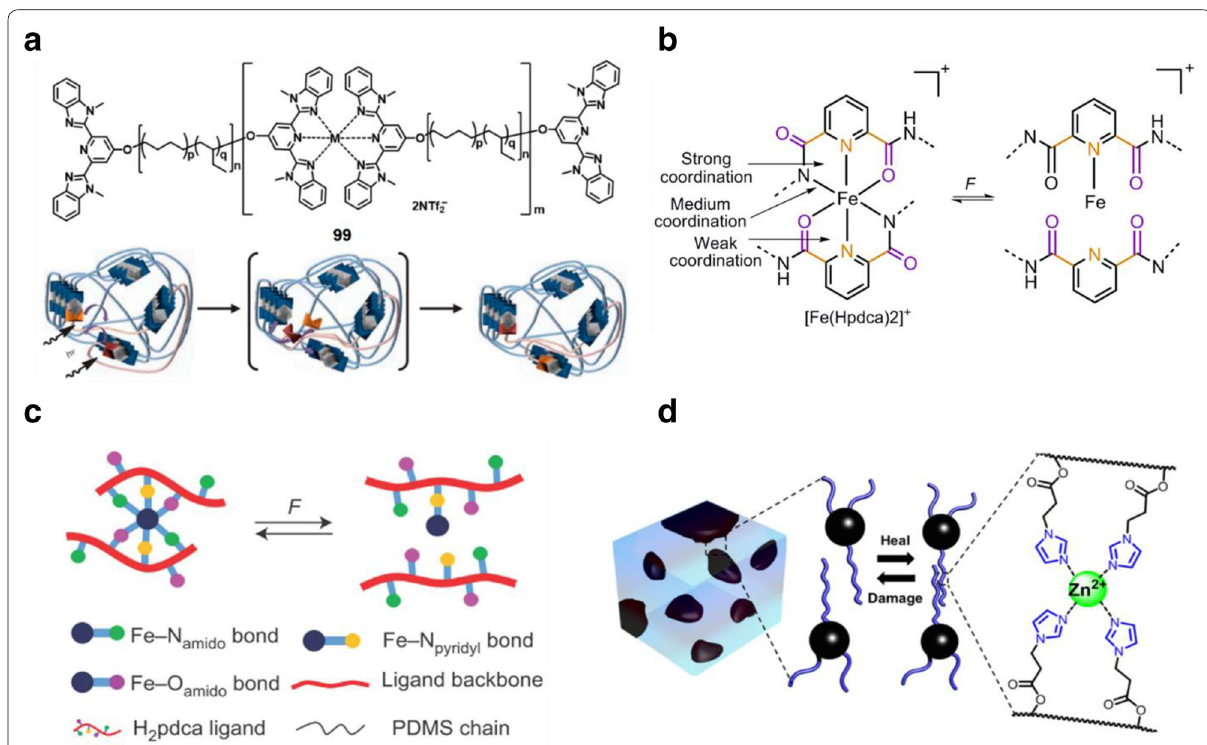
Fig. 7 a Mechanism and synthesis of phase segregated healable metallosupramolecular polymers via assembly of 2,6-bis(1-methylbenzimidazolyl) pyridine (Mebip) ligands coordinated with Zn(NTf) 2 ; b chemical structure and c schematic illustration of PDMS functionalized with 2,6-pyridinedicarboxamide ligands that coordinate to Fe(III) centers and the resulting Fe(III)–N pyridyl , Fe(III)–N amido and Fe(III)–O amido coordination bonds. d Chemical structure and microphase-separated soft\hard two-phase polymer system with metal–ligand interactions as the dynamic motif (figures reproduced with permission from: a Ref. [62], ©2011 NPG; b and c Ref. [28], ©2016 NPG; d Ref. [63], ©2014